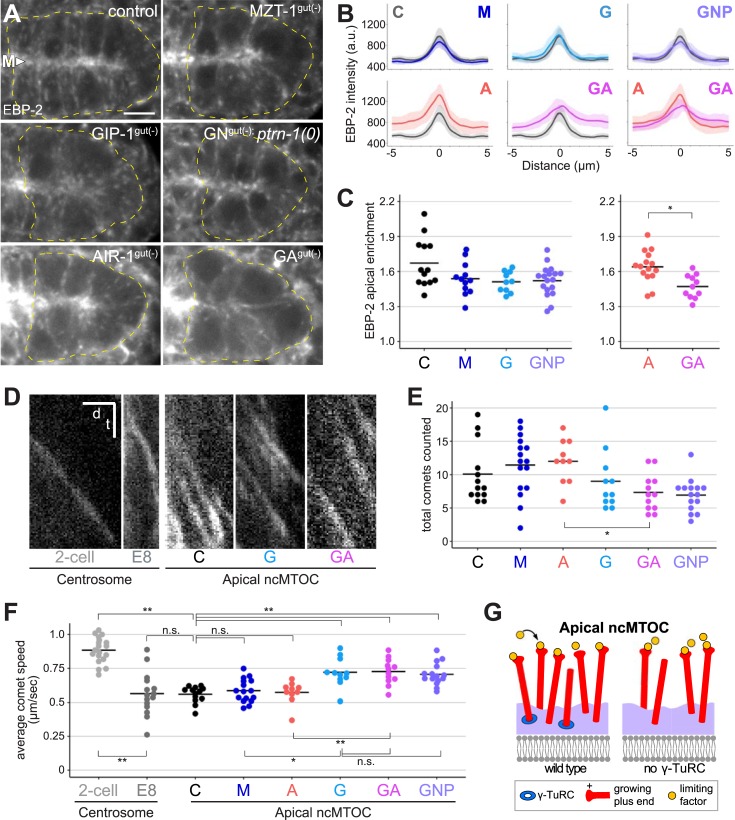
GIP-1 is required for a subset of dynamic microtubules at the apical ncMTOC.(A) Projected 1.5 μm optical sections through the E16 intestinal primordium show EBP-2/EB1::GFP localization in live bean-stage embryos of indicated genotypes. Intestinal primordium is outlined by yellow dashed lines; “M” and arrowhead indicate the apical midline. Scale bar is 5 μm. B) Average EBP-2::GFP pixel intensities along line segments drawn through the midline of polarized intestinal primordia (n ≥ 10, see S3 Fig), with abbreviated genotypes indicated (see Fig 6 legend). (C) Apical enrichment of EBP-2::GFP signal. Apical EBP-2::GFP is significantly reduced only in GIP-1gut(−) embryos compared to control (p = 0.022, two-tailed t test), and in [GIP-1;AIR-1]gut(−) compared to AIR-1gut(−) (p = 0.001, two-tailed t test). Apical enrichment of EBP-2::GFP was compared between most genotypes; because of high AIR-1::ZF::GFP background, apical enrichment of EBP-2::GFP in AIR-1gut(−) is only compared to other genotypes that include AIR-1gut(−) (see Materials and methods). (D–F) Rapid time-lapse imaging was used to measure comet speed and number in the intestinal primordia of live embryos of the genotypes indicated. D) Kymographs of EBP-2::GFP comets in indicated structures and stages. Scale bar is 2 seconds (t) by 2 μm (d). (E) Individual dots show total number of comets crossing two 5 μm lines drawn 3 μm from either side of the apical midline in an individual embryo. (F) Average speeds of comets growing from either individual centrosomes (“2-cell”; “E8”) or an apical ncMTOC from a single embryo (“C,” “G,” “A,” “GA”) of the indicated genotype and stage. Total number of comets analyzed per genotype ≥30. Comet speed is significantly increased in “G,” “GA,” and “GNP” compared with control embryos (p < 0.0005, two-tailed t test, see Materials and methods). In (C–F), *p < 0.01, **p < 0.001 by two-tailed t test. (G) Limiting factor model: loss of γ-TuRC leads to fewer growing microtubules, freeing up a limiting factor that promotes faster microtubule growth at remaining dynamic microtubules. A, AIR-1gut(−);C, zif-1(−) control; G, GIP-1gut(−); GA, [GIP-1; AIR-1]gut(−); GFP, Green Fluorescent Protein; GNP, [GIP-1; NOCA-1]gut(−); ptrn-1(0); M, MZT-1gut(−);ncMTOC, non-centrosomal microtubule organizing center; n.s., not significant; ZF, zinc finger domain 1; γ-TuRC, γ-tubulin ring complex.